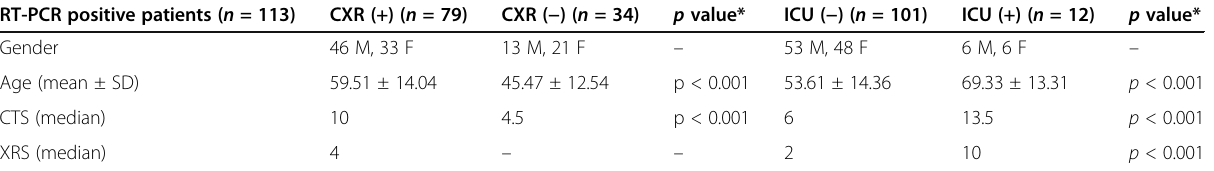
Table 4 Comparison of patient groups based on CXR positivity and intensive care necessity ( n = 113) RT-PCR positive patients ( n = 113)